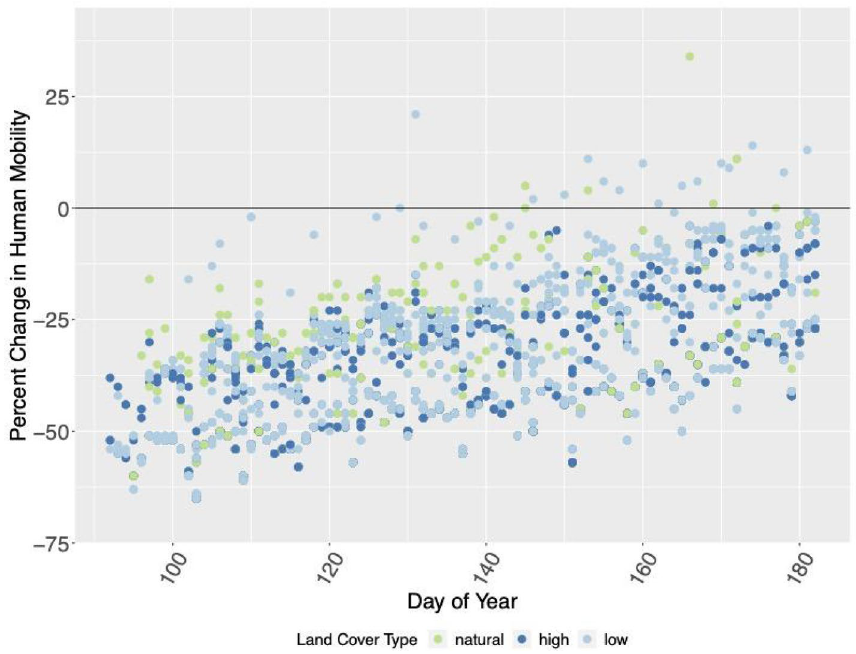
Figure 2. Daily percent change in human mobility relative to a pre-pandemic baseline over the course of the study period. Each dot represents a survey included in our analysis, color coded by the land cover type of the monitoring site (green = natural areas, dark blue = highly developed, light blue = less developed). Negative values indicate that human mobility was lower than it was before the pandemic. Note that human mobility was suppressed across the study area during COVID-19 pandemic